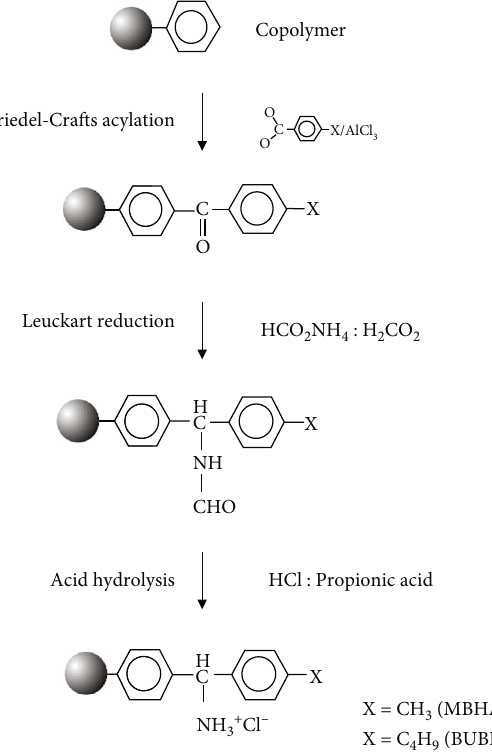
Scheme 1: Synthesis scheme of MBHAR and